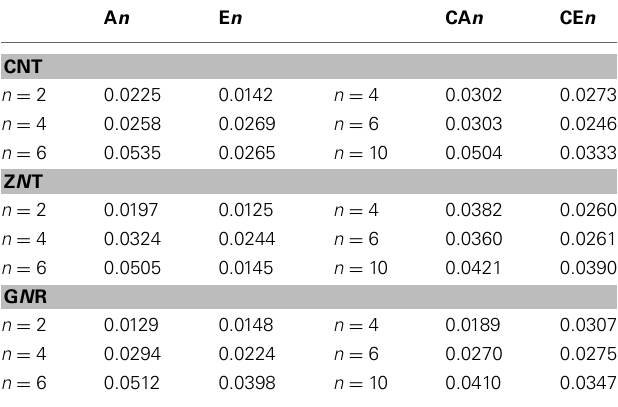
Table 4 | Sum of the electron densities at the LCPs of CNSs-hydrocarbon complexes in a.u. obtained by AIM